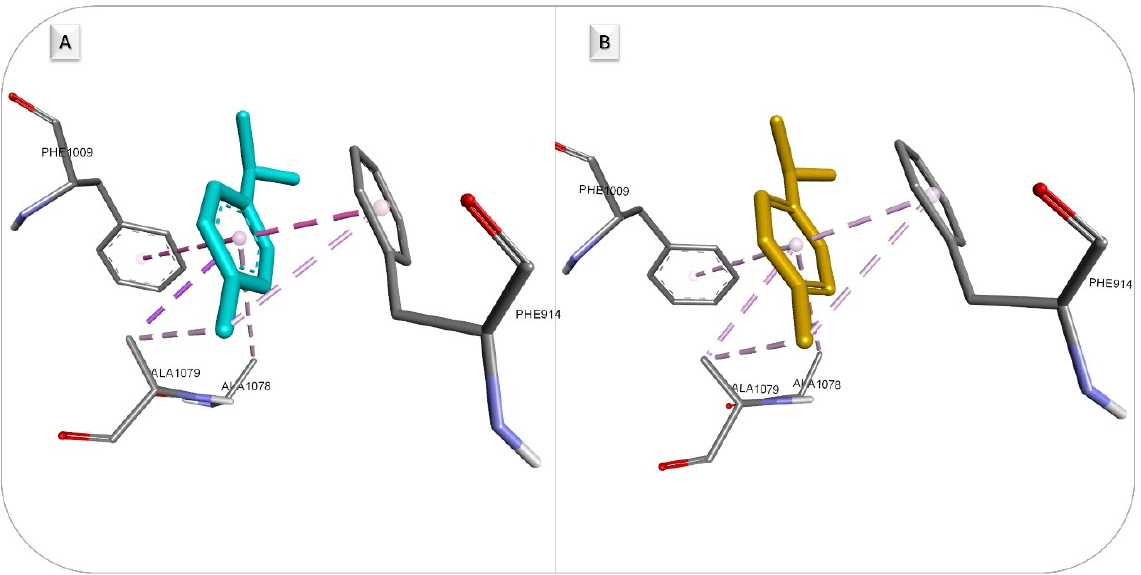
Figure 4. Xanthine oxidase (3NRZ) structure in complex with docked compound ( A ) para-cymene (cyan) and ( B ) gamma-terpinene (gold) with interacting amino acids (grey sticks) via hydrophobic interactions (pink/purple-dotted lines). Interatomic length between interacting atoms varied between 3.61–5.21 Å.